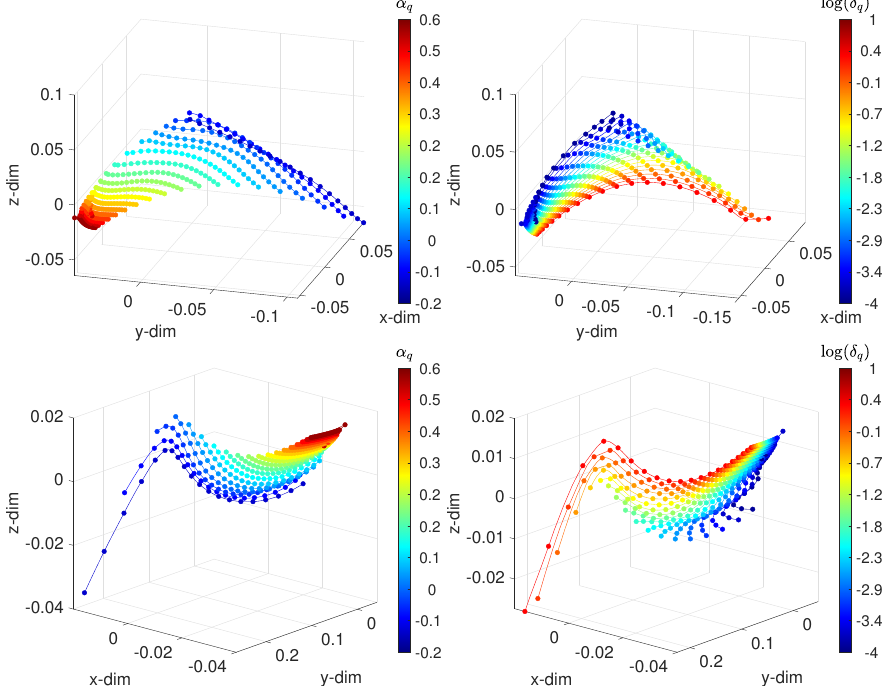
Figure 8. The 3-dim MDS locus for the FVSC-ISM, assessing the frequency-domain behavior, with the distances: ( top ) ( f ) ( f ) ( f ) ) ; and ( bottom ) Jaccard d ( v ( f ) ) . The points represent the test cases. On the left, lines connect Arccosine d 1 ( v , v , v 2 i j i j points of constant δ , and each color corresponds to points of constant α . On the right, lines connect points of constant α , and each color corresponds to points of constant δ . The fractional order α q ∈ [ − 0.2,0.6 ] , the width of the band δ q ∈ [ 10 − 4 ,10 1 ] , and f r ∈ [ 10 − 2 ,10 2 ]